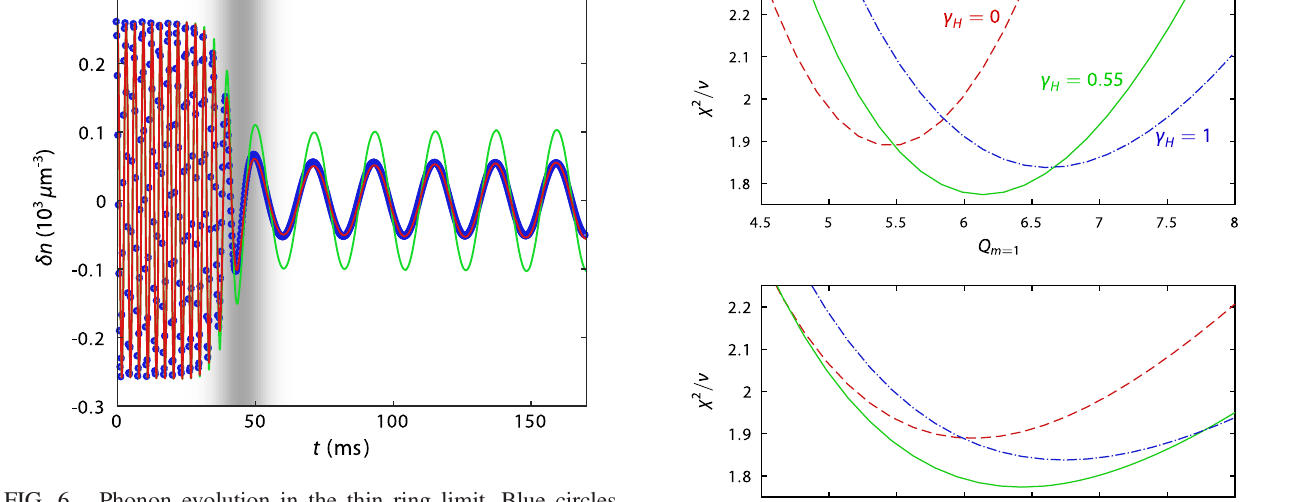
(2012).FIG. 6. Phonon evolution in the thin ring limit. Blue circles show 2D GPE simulation data; the red (green) curve is the solution to Eq. (C13) with (without) the term included. The gray band indicates the time during which the BEC is inflated; its intensity denotes the expansion velocity relative to the maximum.